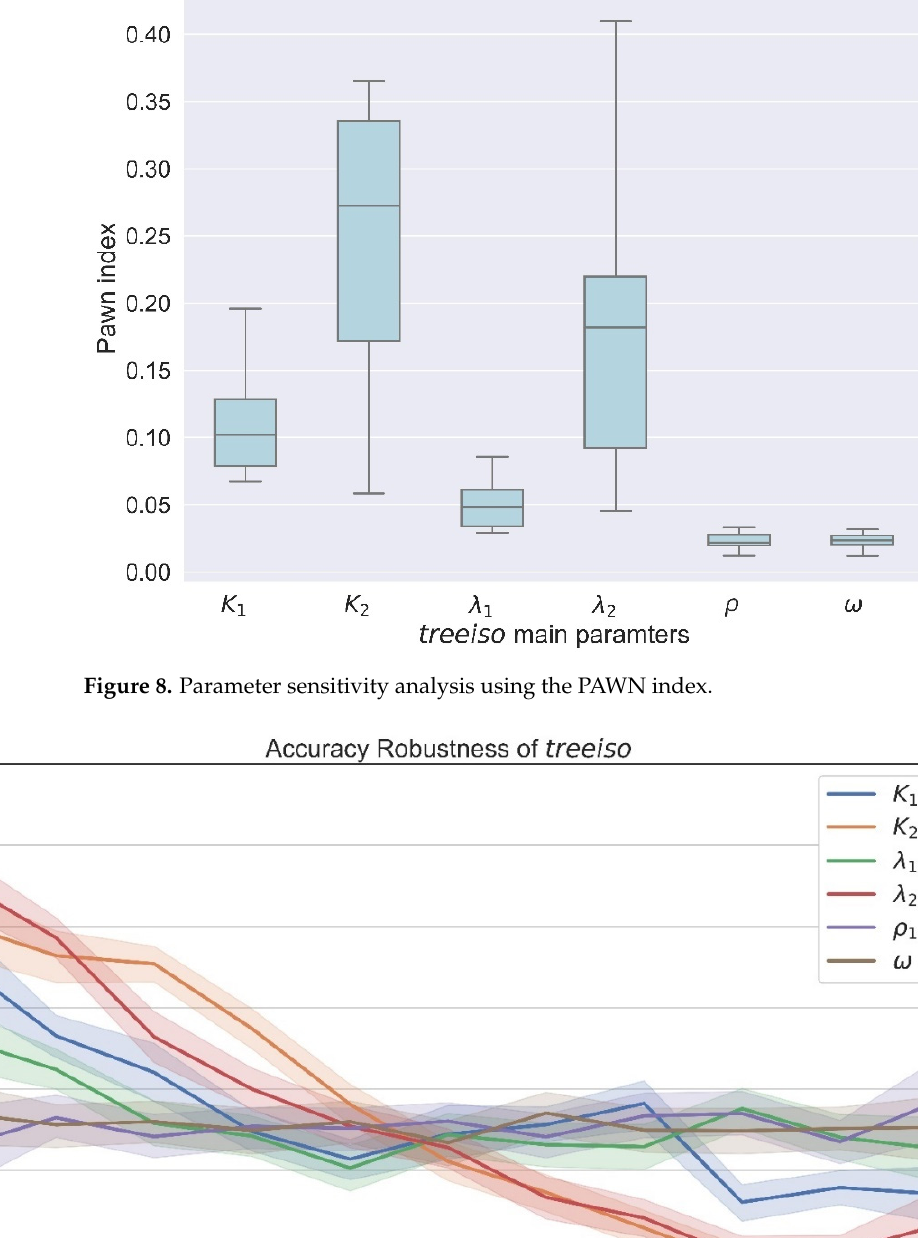
Figure 8. Parameter sensitivity analysis using the PAWN index.